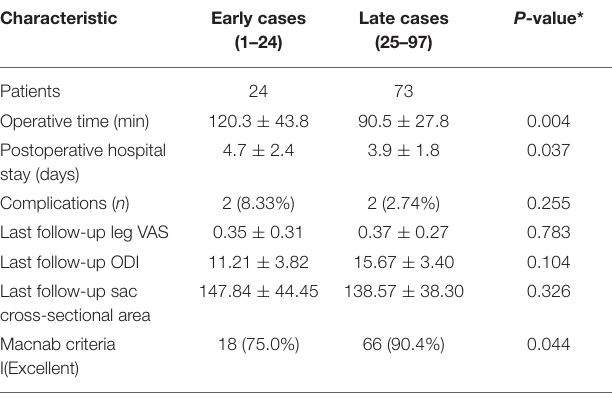
TABLE 4 | Clinical effect characteristics stratified by learning